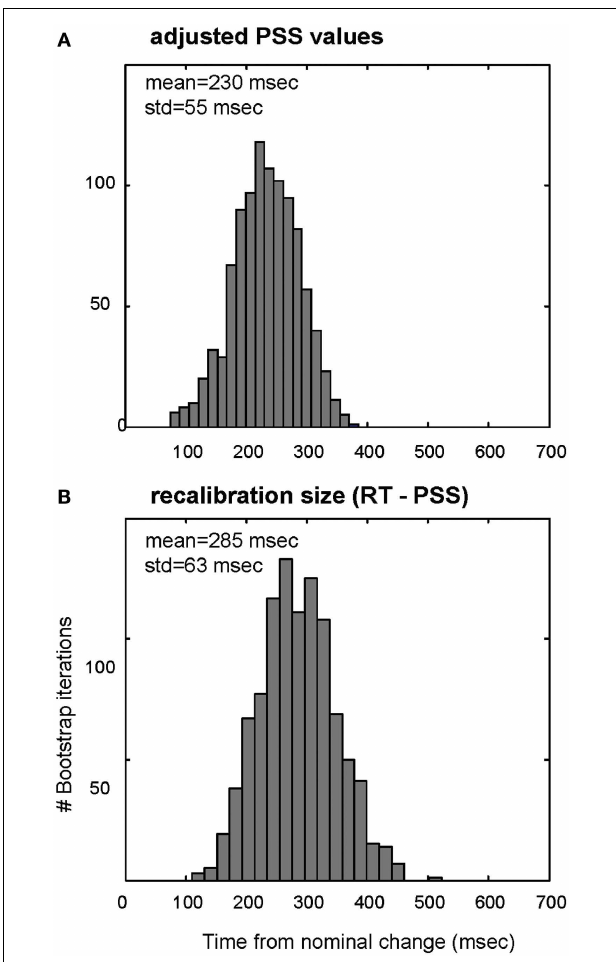
FIGURE 5 | Distributions of RAND-REG adjusted PSS values (A) and recalibration size (B) in Experiment 2 as computed with bootstrap resampling. (A) Gray bars: histogram of average PSS values obtained with a “repeated measures” bootstrap procedure, by which we repeatedly select with replacement a set of 15 subjects, estimate each individual PSS (including correction of RAND-REG PSS by the PSS of REG-RAND), compute the average over the group, and increment the appropriate histogram bin. (B) Same for recalibration size